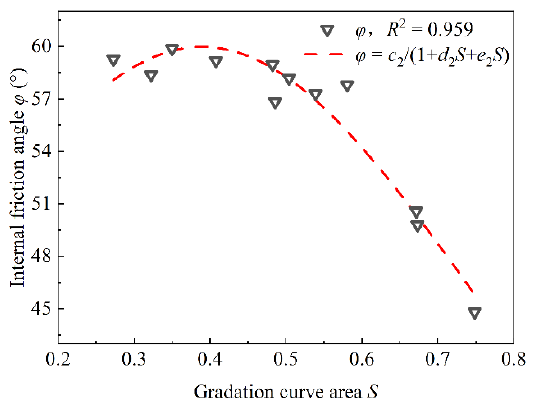
Figure 10. Relationship between gradation curve area and cohesion.